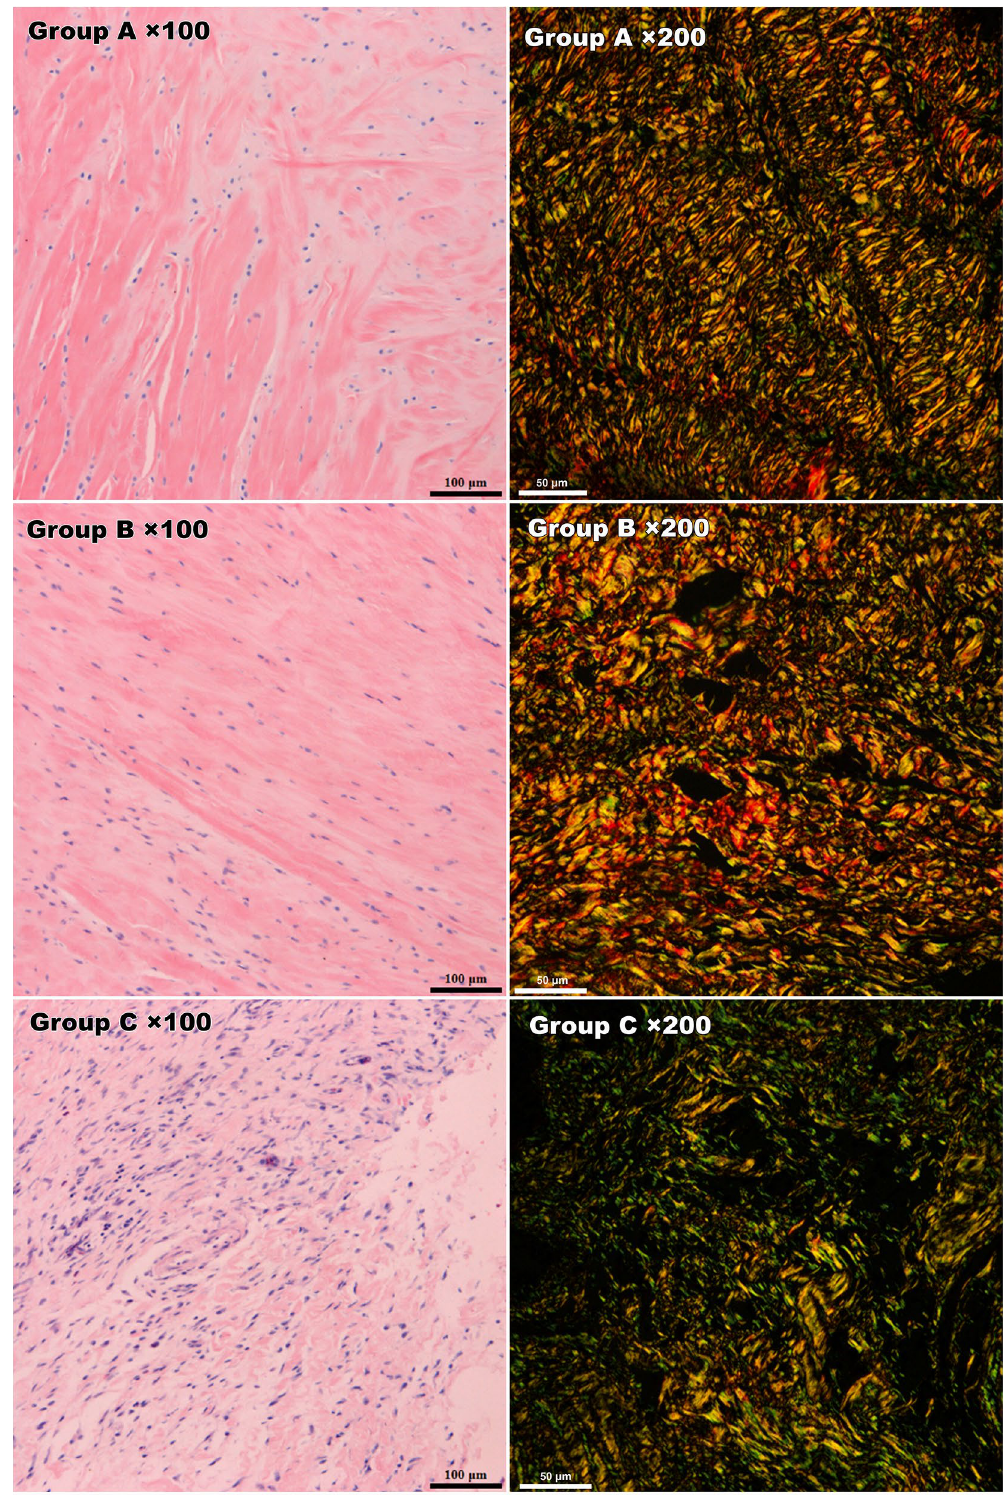
Figure 5. HE staining and picrosirius red staining of rotator cuff tissues under microscopy. Fibroblast proliferation and inflammatory manifestations were observed in group C (left column). Under polarized light microscopy, the overall alignment and proportion of collagen I/III in group C obviously differed from those in groups A and B based on Sirius red staining (right